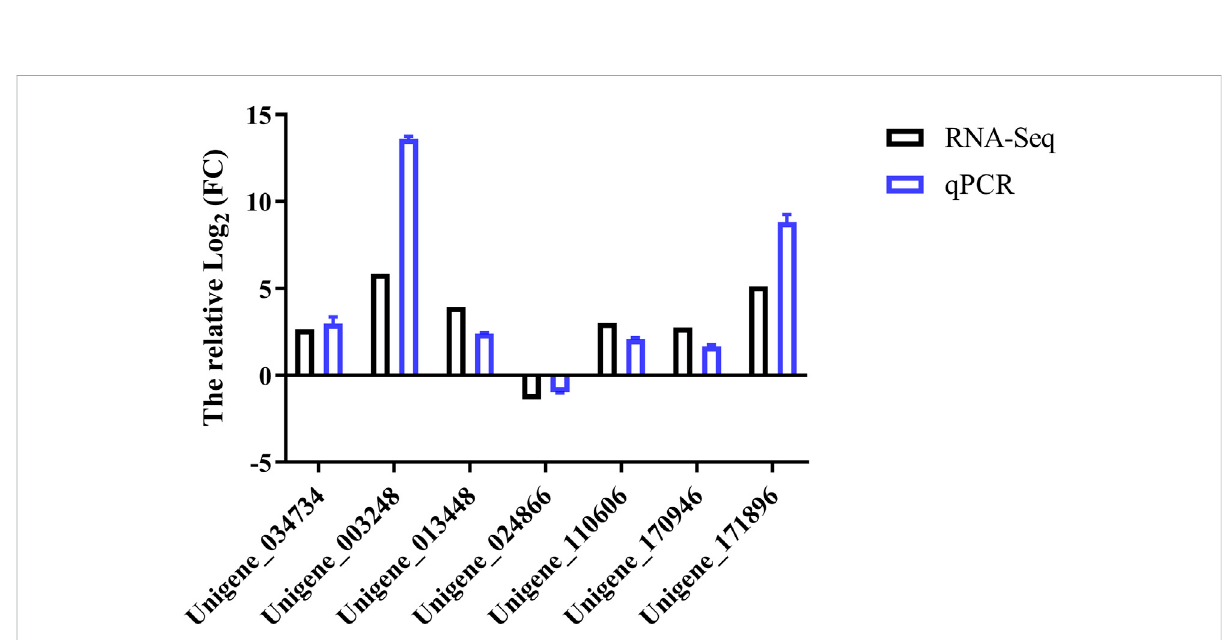
FIGURE 6 qRT-PCR and RNA-Seq analysis results of differentially expressed genes in Binodoxys communis